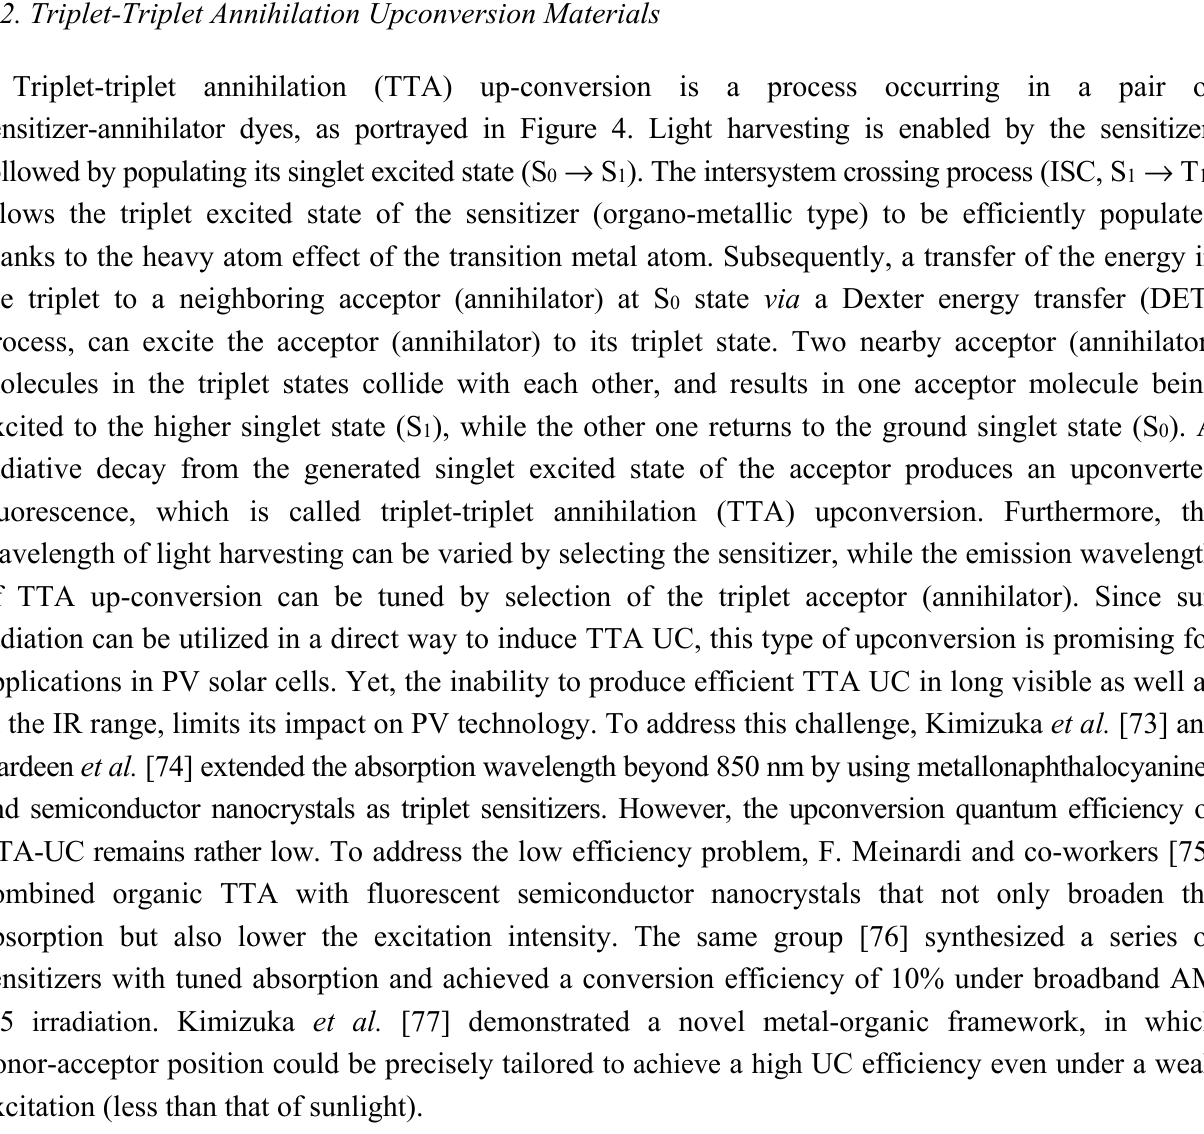
Figure 3. The upconversion mechanisms for ( a ) single Er 3+ doped upconversion particles (UCNPs) excited under 1523 nm laser exciation; ( b ) Nd 3+ -Yb 3+ -Er 3+ tridoped system under 808 nm or 980 nm laser